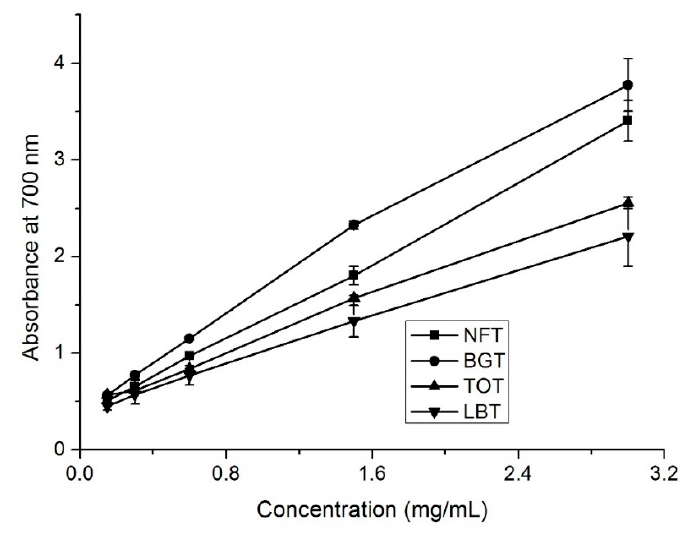
Figure 2. Reducing power of different tea samples. NFT, novel fermented tea; BGT, Boseong green tea; TOT, Tieguanyin oolong tea; LBT, Lipton black tea.